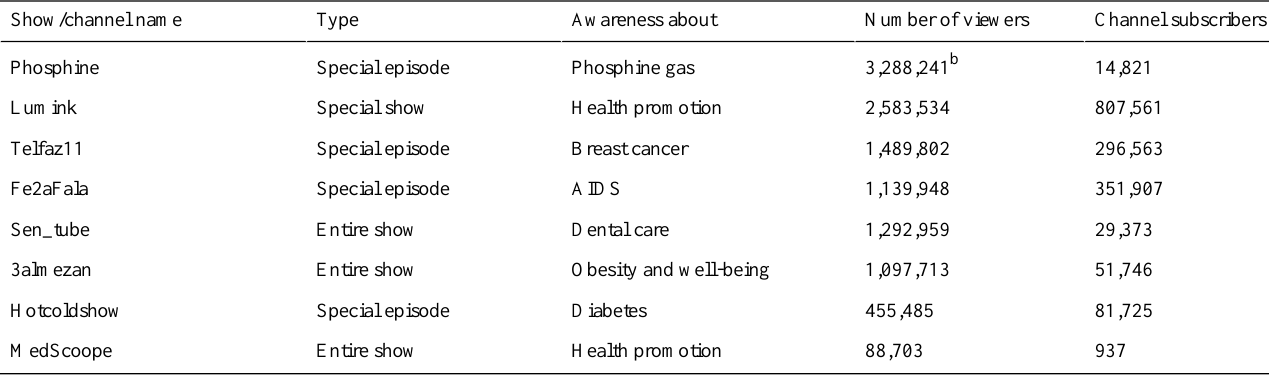
Table 4. Health messages delivered through Saudi YouTube-based shows.